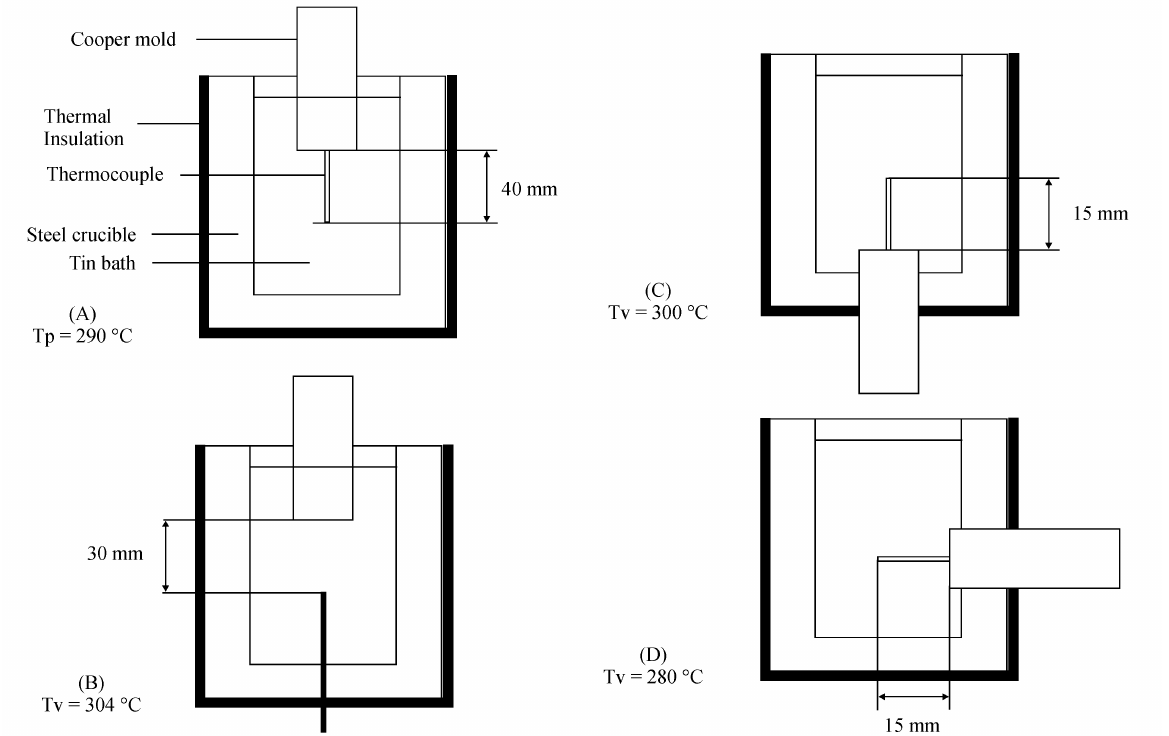
Figure 7. Schematic representation of the ‘‘cold-finger’’ system used in this work to test some ideas derived from the MS Model. The idea was to use the contraction exerted by the solid to assure a ‘‘ quasi-perfect’’ thermal contact with the metallic mold during solidification, one of the basic assumptions of the Schwarz Model. Natural thermal convection, has been changed from maximum (A and B), medium (D), and minimum (C) 9